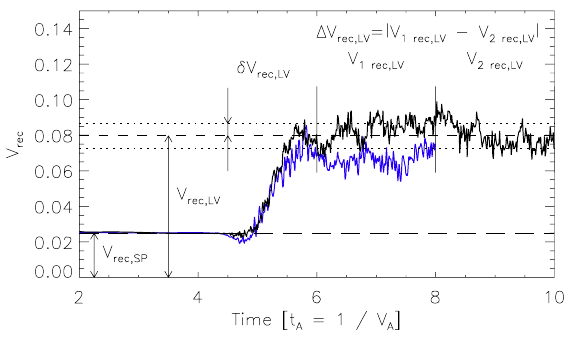
Fig. 3. Evolution of total mass M and kinetic and magnetic energies E kin and E mag , respectively. Two dotted vertical lines bound the period of gradually increasing turbulence. The resistivity in this model is set to η = 10 − 3 and the shared component of magnetic field B 0 z = 0 . 1. In this model, we inject turbulence in the magnetic field.